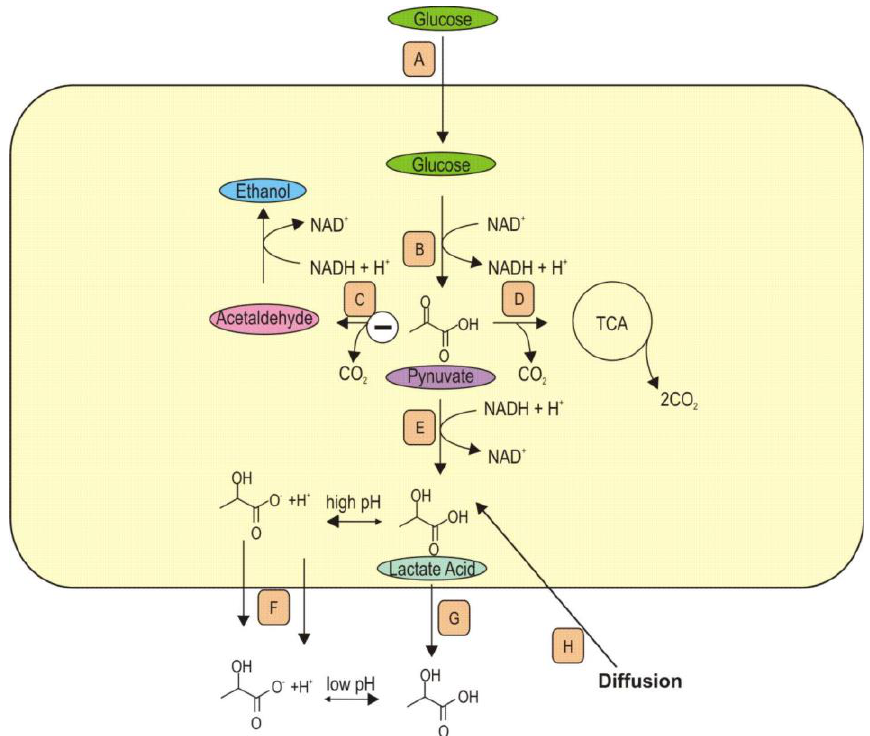
Figure 7. Schematic diagram of the metabolic pathway of lactic acid production in genetically modified Saccharomyces cerevisiae . A: Transport of glucose via hexose transporters; B: The release of 1ATP per molecule of pyruvate formed (glycolysis); C: Non-oxidative decarboxylation of pyruvate to acetaldehyde and carbon dioxide by pyruvate decarboxylase (PDC); −: Decrease or deletion of PDC activity; D: Oxidative decarboxylation of pyruvate catalyzed by pyruvate dehydrogenase via the tri-carboxylic acid (TCA) cycle; E: Lactic acid production from pyruvate catalyzed by lactate dehydrogenase as a result of introducing heterologous activity by genetic engineering; F: Lactate/H + symport (for exporting lactic acid); G: Lactic acid export from the cell and H: Lactic acid protonation and diffusion into the cell (when the extracellular lactic acid is low) (Adapted from Zhu et al. (2022) [145]).